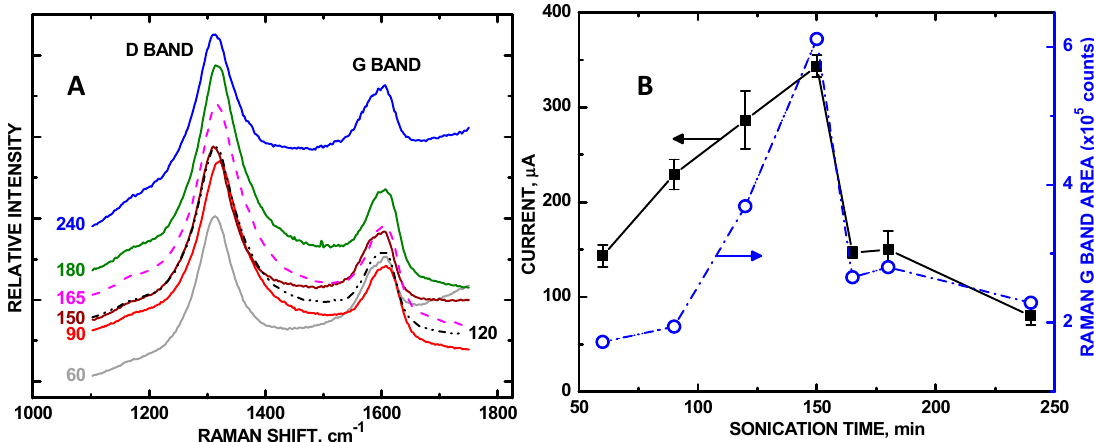
Figure 5. ( A ) Stack plot of Raman (raw) data with offset for 60, 120, 150 and 165 min showing diamond D and G bands, respectively; ( B ) potentiostat current of 10 mM UA in PBS (pH = 7.0) from CVs at +0.577 V vs. Ag/AgCl (left-hand axis) and Raman G band integrated peak area (right-hand axis).